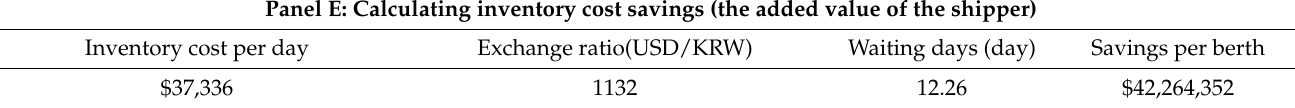
Panel E: Calculating inventory cost savings (the added value of the shipper)